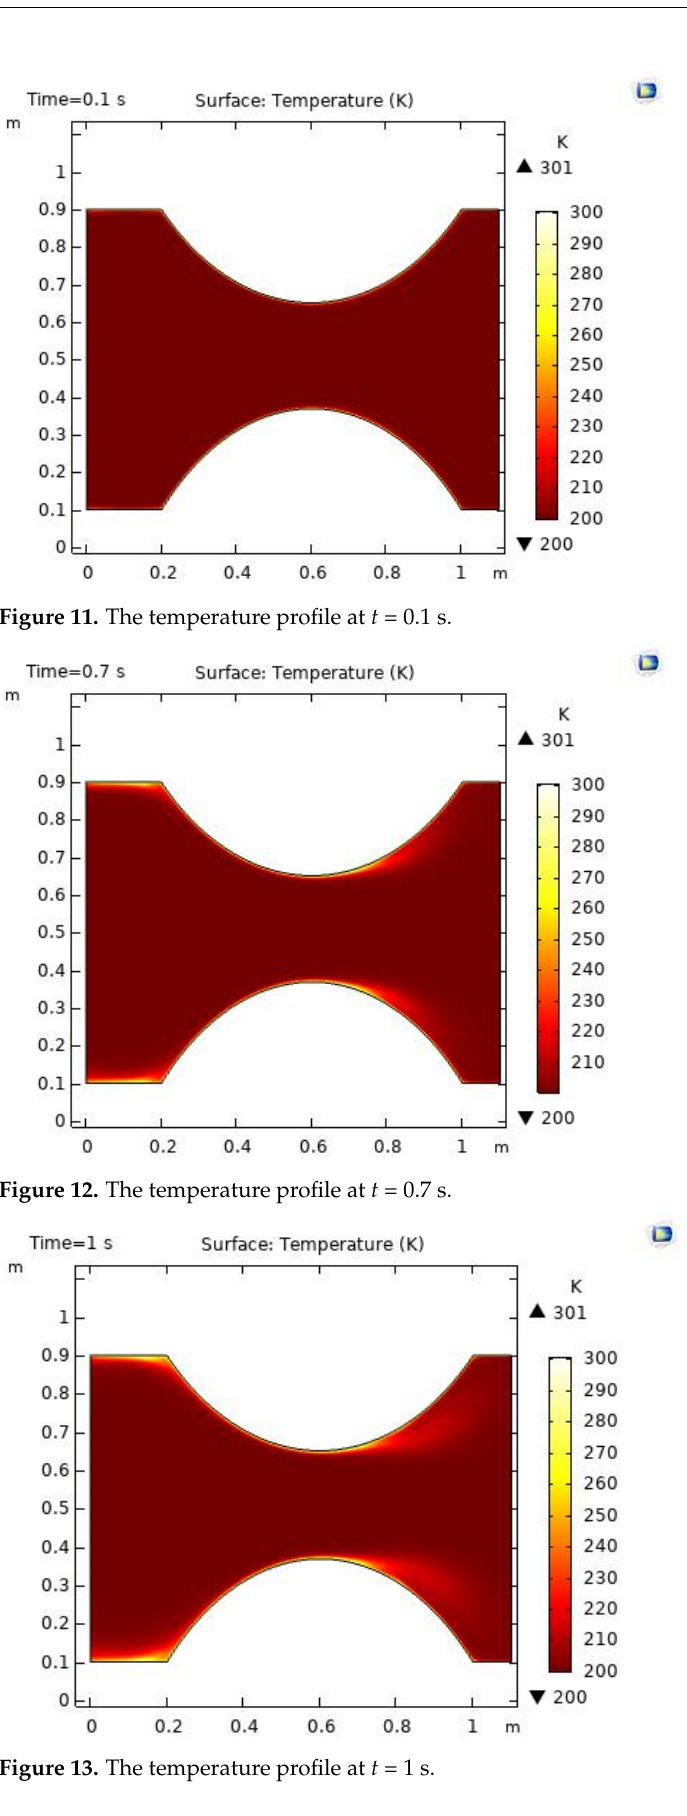
Figure-14. The pressure profile at t = 0.1 s.